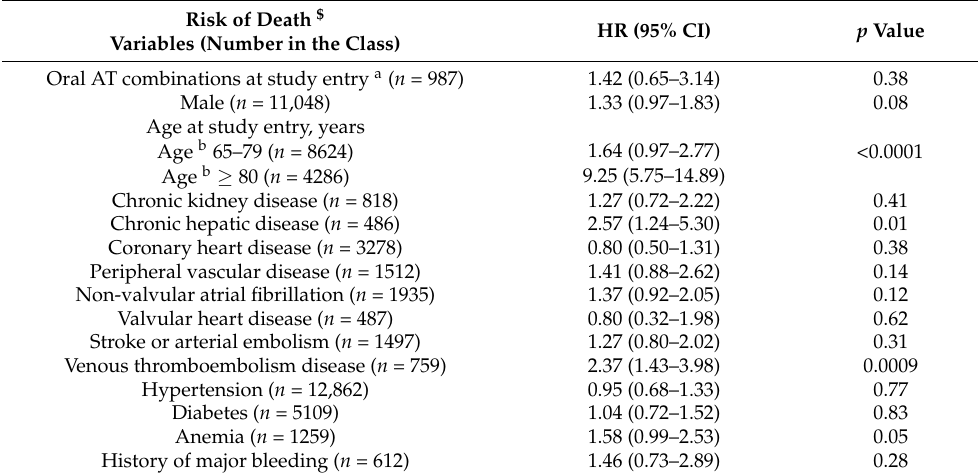
Table 4. Risk of death in individuals starting the study with oral antithrombotic (AT) combinations ( n = 987) versus individuals starting the study with oral AT monotherapy ( n = 21,233) as a reference (estimated by the Fitted Cox